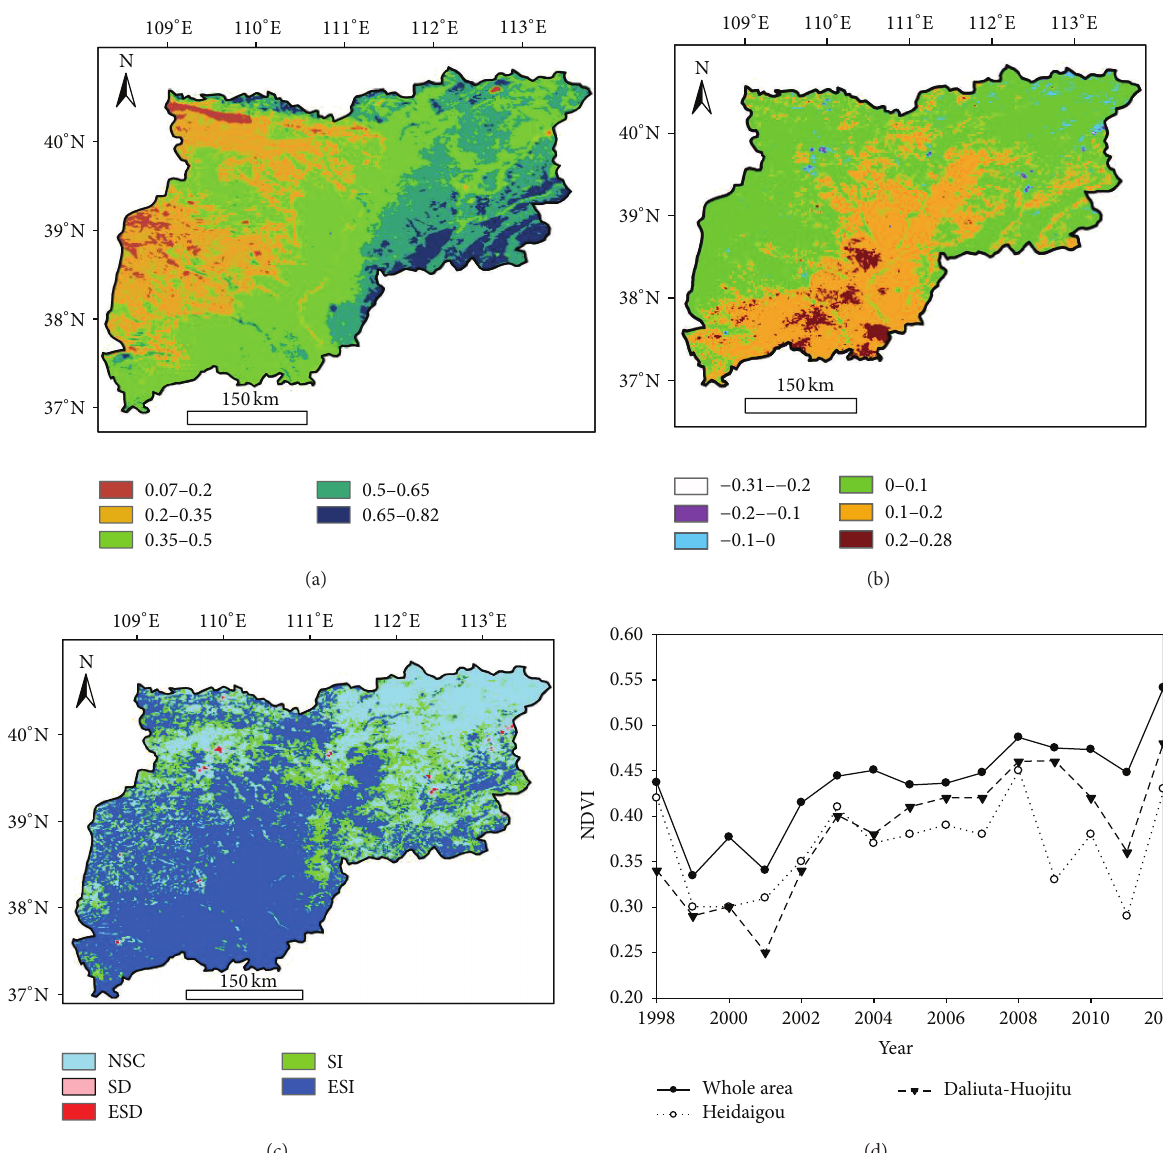
Figure 2: (a) The spatial distribution of the annual maximum NDVI; (b) the NDVI trends; (c) the significance level of the NDVI trends; and (d) the interannual NDVI changes for the northern Loess Plateau from 1998 to